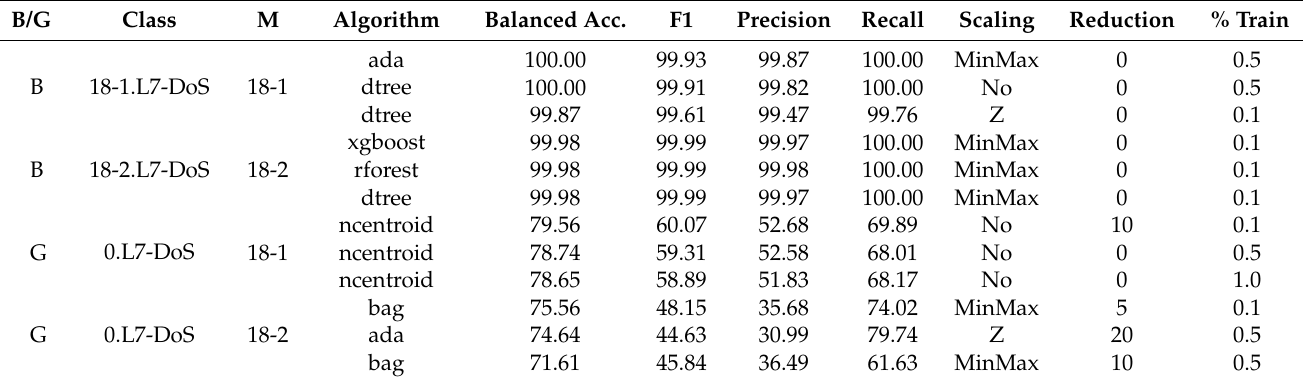
Table 8. CIC-DoS2017 data classification metrics by DoS models pretrained on CSE-CIC-IDS2018 for the best 3 models per attack class, both for baseline (B) and generalized (G) classification, with mention of the preprocessing parameters.